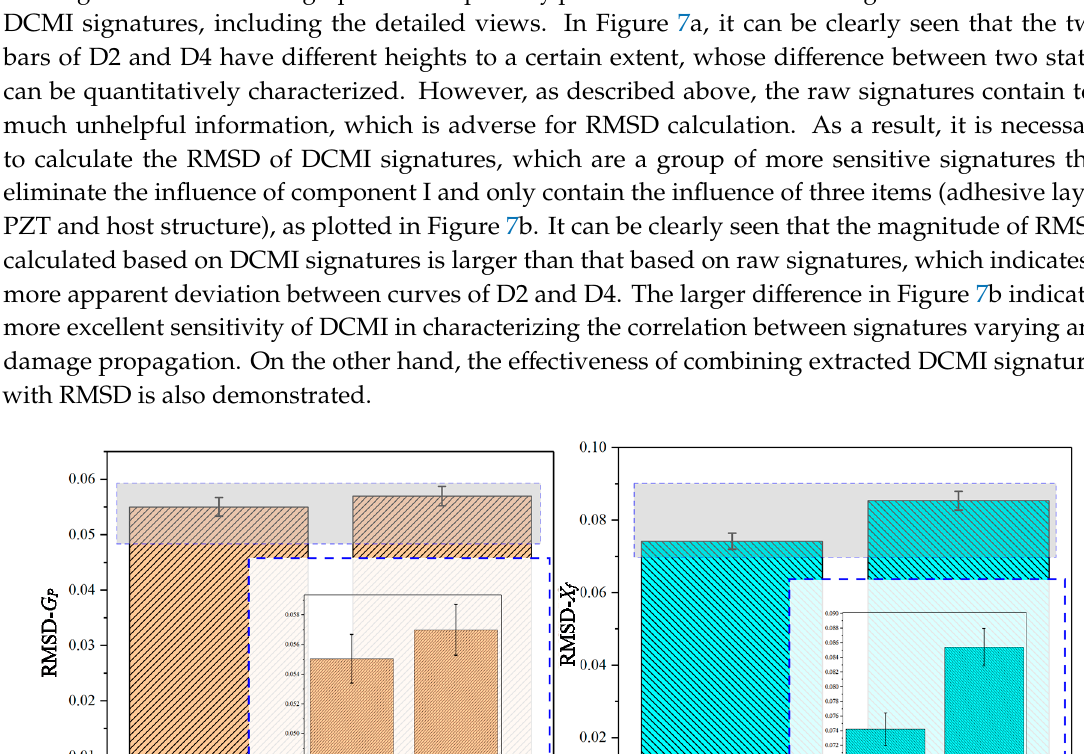
Table 5. root mean square deviation (RMSD) based on raw signatures and DCMI signatures of specimen-1.